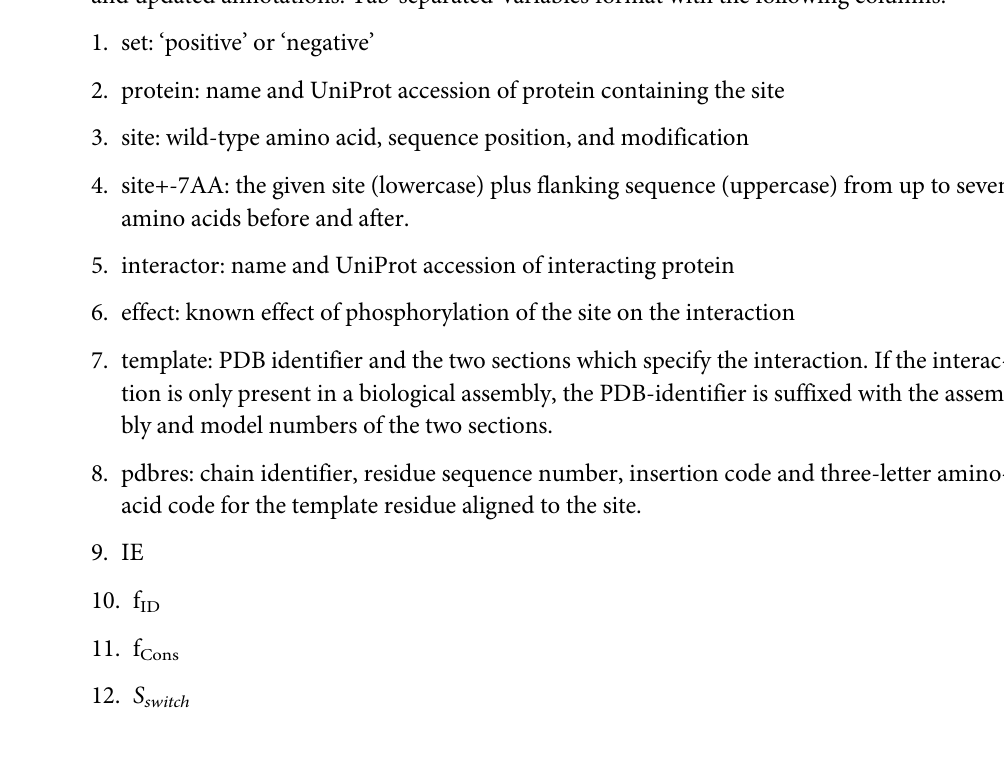
different (P << 0.01), with phosphosites more likely to be conserved. The left and right- hand axes are scaled to the number of non-redundant phosphosites and background sites, respectively, that were mapped to interfaces of interaction structures. S3 Fig. Receiver Operator Characteristic (ROC) curves showing the ability of absolute interaction effect (abs(IE)), similarity of the query to the template structure (f ) and the ID conservation of the site across orthologues (f ) to identify phosphosite switches irre- Cons spective of the direction of the effect. S4 Fig. Top panel: Receiver Operator Characteristic (ROC) curves showing the ability of to identify enabling or disabling effects of known phosphosite switches, the change S switch in performance by including the interaction effect (IE, = sum of pair-potentials), similarity of the query to the structure template (f ), and the conservation of the site across ortholo- ID gues (f ), along with performance of logistic regression (LR final) using the same fea- Cons tures and the performance of ΔΔ G calculated by FoldX. Bottom panel: Precision-Recall curves for the same set of predictors. S5 Fig. The Dynein Ser-88 phosphosite is known to disable homodimerisation [40] but FoldX gives a negative ΔΔ G (-4.83 Kcal/mol), with energy minimisation causing the two Ser- ines that point towards each other in the unphosphorylated structure (top) to point away from each other when phosphorylated (bottom) rather than preventing dimerisation [35]. S1 Table. Phosphoswitch benchmark set. (Data file ’S1_table_benchmark.txt’.) Please check the given effect in original sources (UniProt and PhosphoSitePlus) in case of new information and updated annotations. Tab-separated-variables format with the following